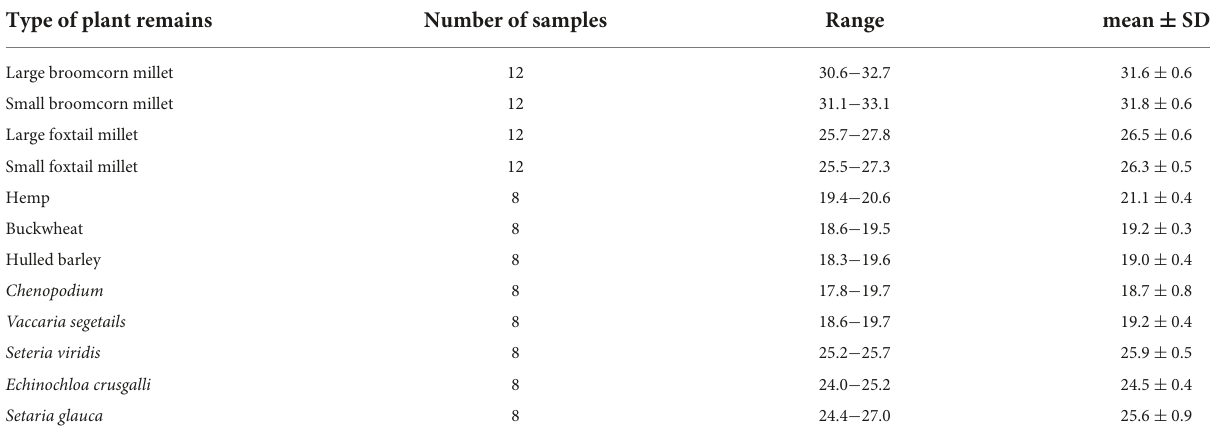
TABLE 2 Summary results of δ 18 O for the plant remains from the Chashancun